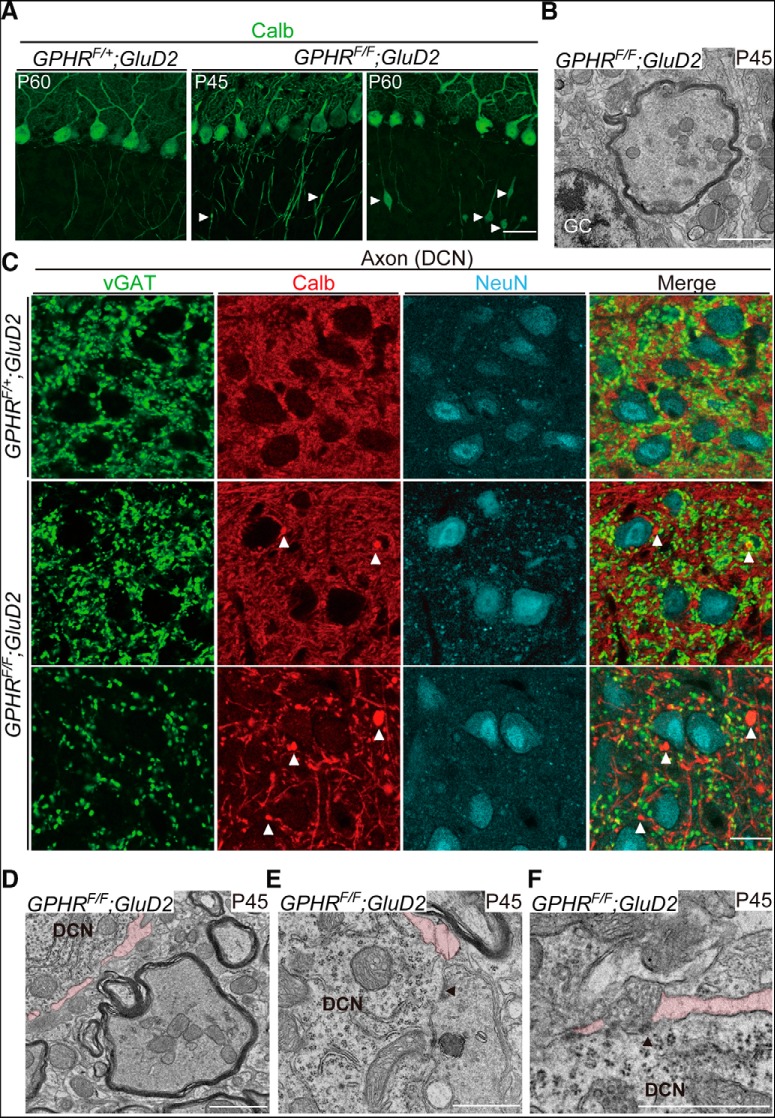
Axonal swelling and abnormal synaptic terminal formation in GPHR-deficient PCs. A, Immunofluorescence for calbindin (Calb; green) in the PC layer of GPHRF/+;GluD2-Cre mice at P60 and GPHRF/F;GluD2-Cre mice at P45 and P60. Arrowheads indicate axon swellings. Scale bar: 20 µm. B, Electron micrographs show axon swelling in the granule cell layer at P45. GC, granule cell. Scale bar: 1 µm. C, Triple immunofluorescence for vGAT (green), calbindin (Calb; red), and NeuN (cyan) in the DCN of GPHRF/+;GluD2-Cre mice at P60 and GPHRF/F;GluD2-Cre mice at P45 and P60. PC axon terminal swelling in the DCNs of GPHRF/F;GluD2-Cre mice. Arrowheads indicate swellings in the distal axons or axon terminals positive for calbindin. Scale bar: 20 µm. D−F, Electron micrographs showing an axonal swelling in the DCN region (D), an abnormal synaptic terminal (E), and intercellular spaces (highlighted by pink) on and around the DCN neuron, respectively, at P45. An arrowhead indicates the active zone. Scale bars: 1 µm. For A−F, three mice per genotype were used; n = 5 sections per mouse; representative images are shown.